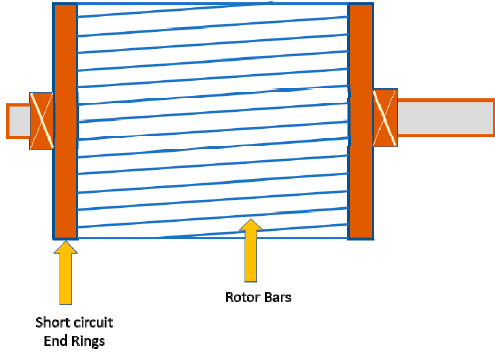
Figure 1. Illustration of a caged rotor of a RCIM.